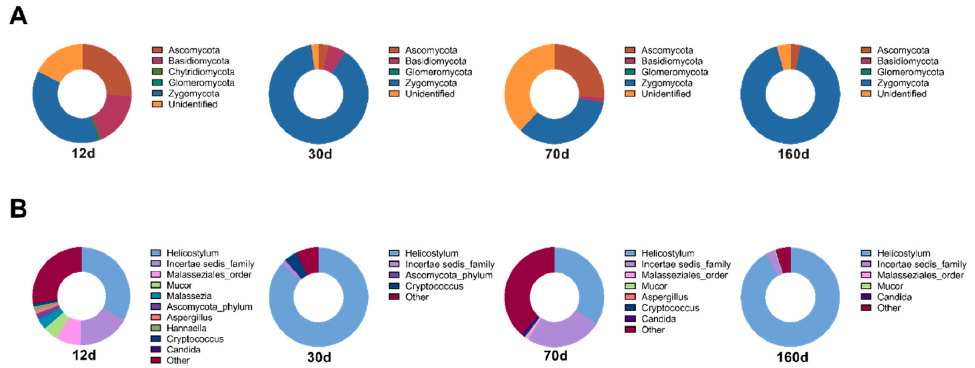
Figure 5. Relative abundance (%) plots of the mycobial communities on the surface of dry aged beef with respect to the aging periods. The top ten most abundant fungi at the phylum level ( A ) and genus level ( B ) are represented, and the rest of the fungal strains were pooled in the ‘others’ category.